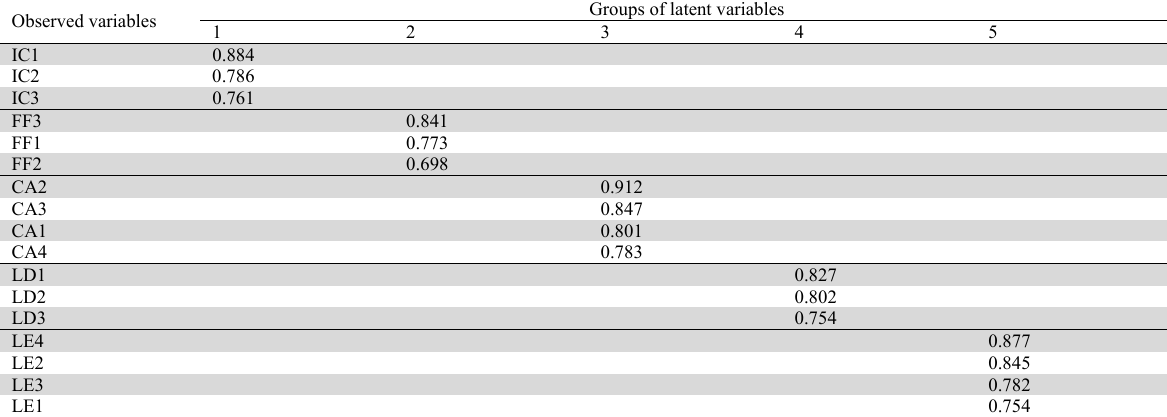
Table 7 Weights of the rotation matrix.